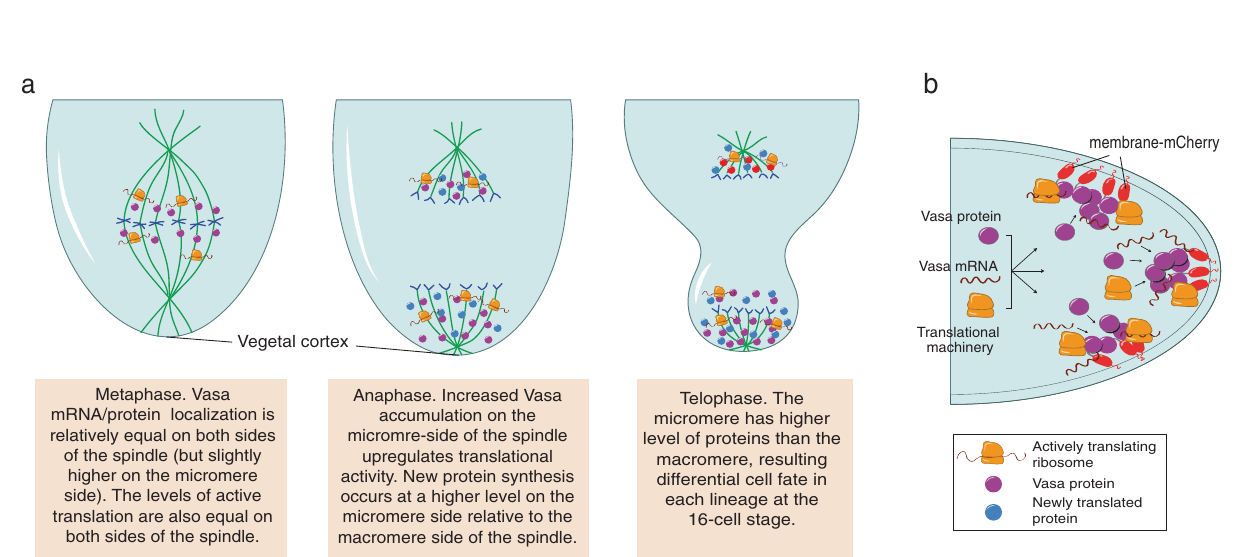
Fig. 8 Models for Vasa enrichment and new protein synthesis on the mitotic spindle. a A model for asymmetric translation on the spindle during micromere formation. Metaphase: Vasa (purple) is equally abundant on both sides of the spindle, so as are levels of active translation. Anaphase: Increased active translation on the micromere side of the spindle facilitates increased Vasa accumulation in the same region. Increased Vasa also increases translation activity, and new protein synthesis occurs at a higher level on the micromere side relative to the macromere side. Telophase: the micromere has a higher level of protein synthesis, resulting in the micromere-speci fi c fate differentiation. b A model for ectopic translation nucleated by membrane- targeted Vasa. Membrane-targeted Vasa recruits Vasa protein, mRNAs, and other spindle-associated molecules as well as translation machinery for ectopic on-site translation on the plasm membrane, which results in cell division and developmental